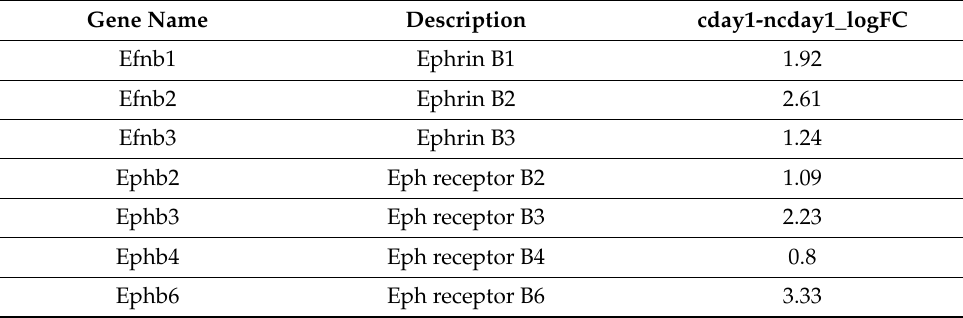
Table 3. Expression of ephrinB and its receptors in chronic